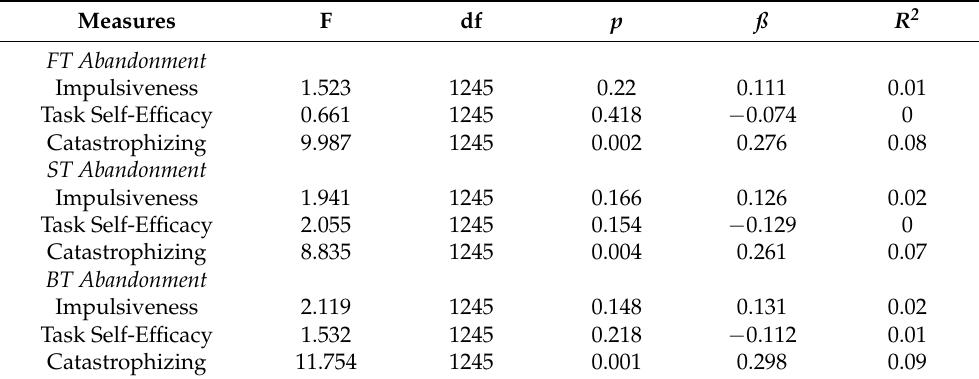
Table 2. Trait predictors of experimental